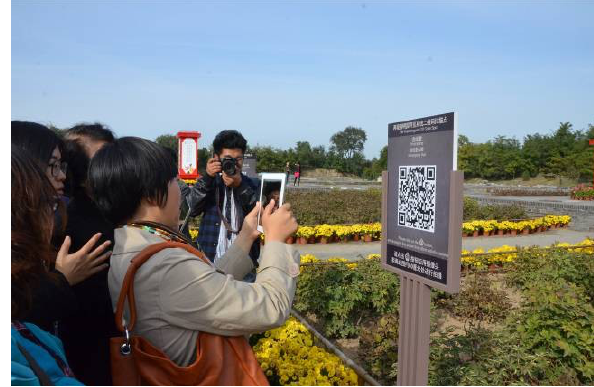
Figure 4. Visitors reading the QR code with an iPad